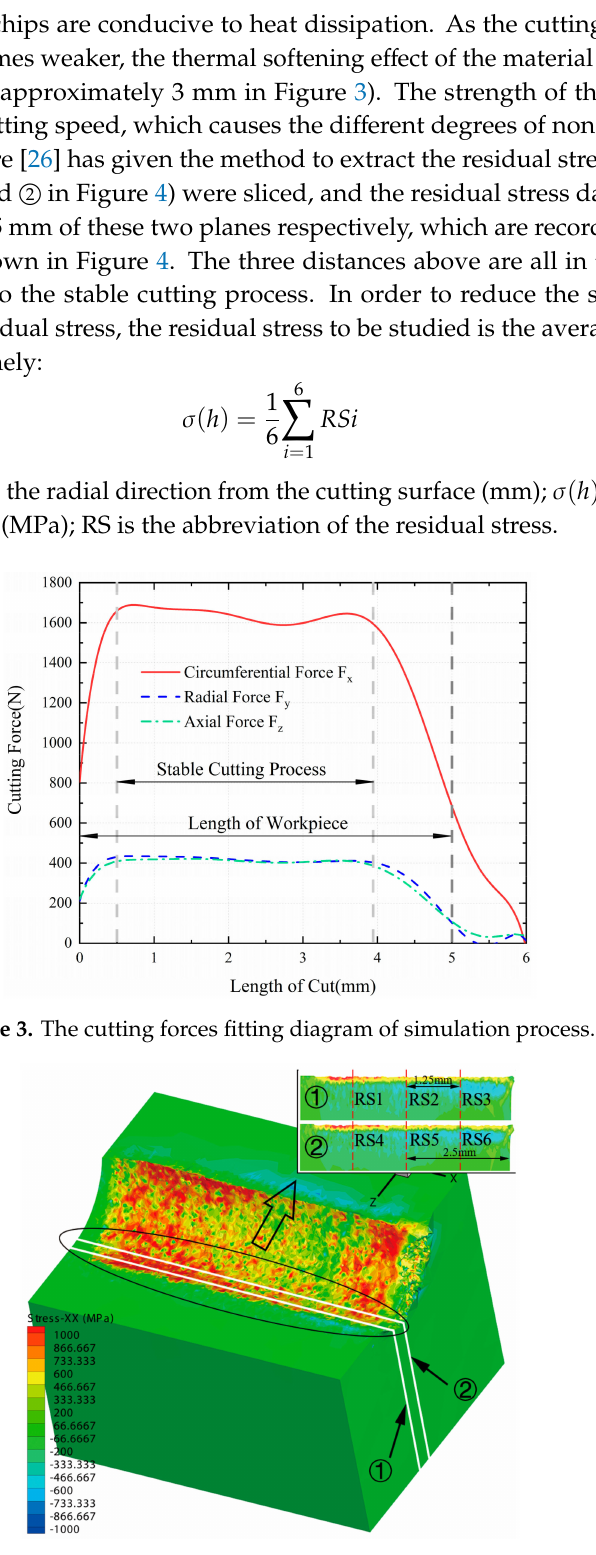
Figure 4. The schematic diagram of residual stress